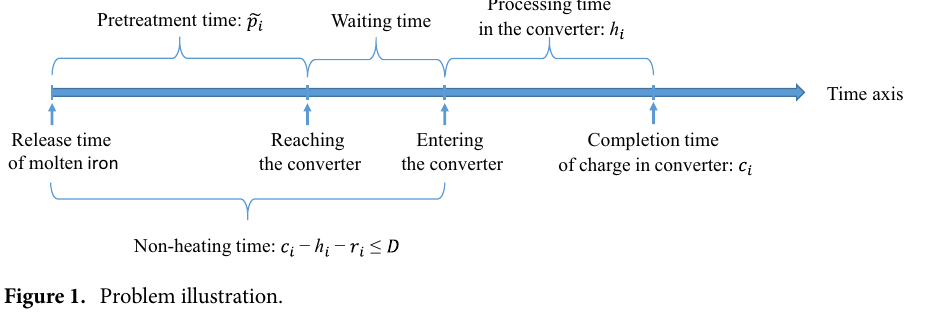
Figure 1. Problem